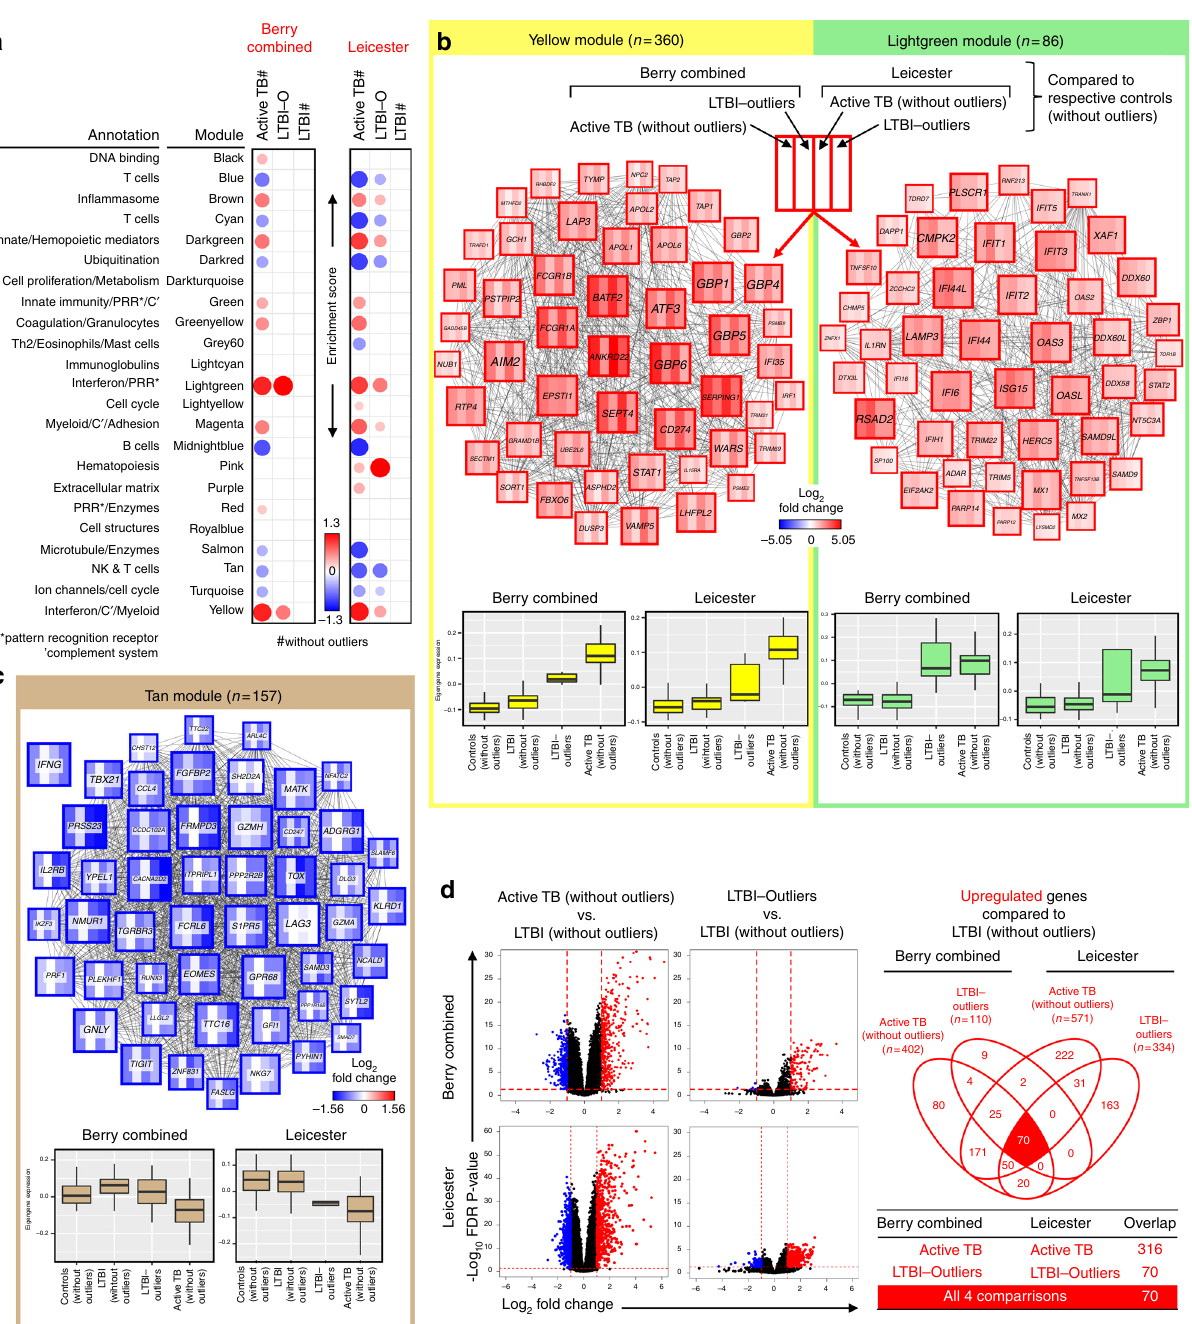
Fig. 9 Blood transcriptional pro fi le of LTBI outliers compared with active TB. a Modules of co-expressed genes tested in LTBI outliers from the Combined Berry and Leicester cohorts. Fold enrichment scores derived using QuSAGE are depicted, with red and blue indicating modules over- or underexpressed, compared to the controls. Colour intensity and size represent the degree of enrichment, compared to the controls. Only modules with fold enrichment scores with FDR p -value < 0.05 were considered signi fi cant and depicted here. b Gene networks depicting the top 50 ‘ hub ’ genes, i.e. genes with high intramodular connectivity, for the yellow, light green and c tan modules. Each gene is represented as a square node with edges representing correlation between the gene expression pro fi les of the two respective genes (minimum Pearson correlation of 0.75). A key describing the four different partitions within each square node is shown, with each partition representing log 2 -fold changes for active TB (without outliers) and LTBI outliers from the Berry Combined and Leicester cohorts, compared to respective controls (without outliers). Red and blue represent up- and downregulated genes, respectively. In the tan module, the expression for IFNG is also shown, although it was not one of the top 50 hub genes within that module. Box plots depicting the module eigengene expression, i.e. the fi rst principal component for all genes within the module, are shown below each gene network. d Volcano plots depicting differentially expressed genes for active TB (without outliers) and LTBI outliers in the Berry Combined and Leicester cohorts, compared to respective LTBI (without outliers). Signi fi cantly differentially expressed genes (log 2 fold change >1 or < − 1, and FDR p -value < 0.05) are represented as red (upregulated) or blue (downregulated) dots, along with a Venn diagram and table summarising overlaps between these different